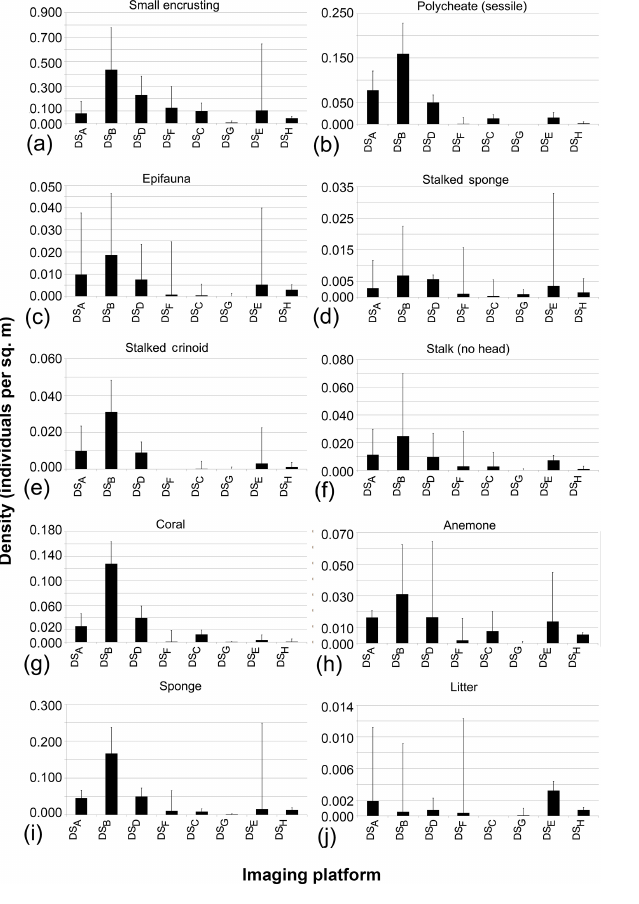
Figure 9. Sessile-fauna abundances averaged across five annotators that independently annotate image data collected during the eight survey